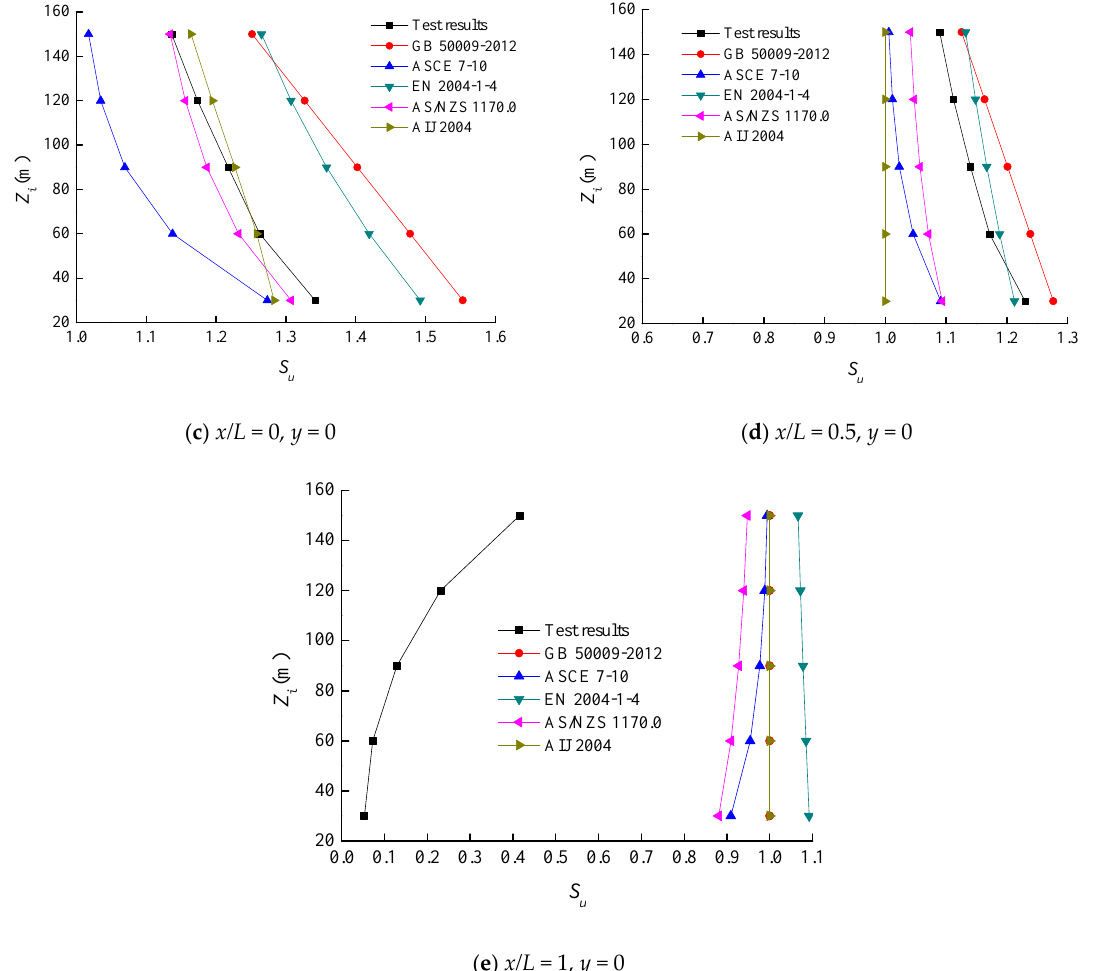
Figure 15. Comparison of speed ‐ up Su between tests and various standards.